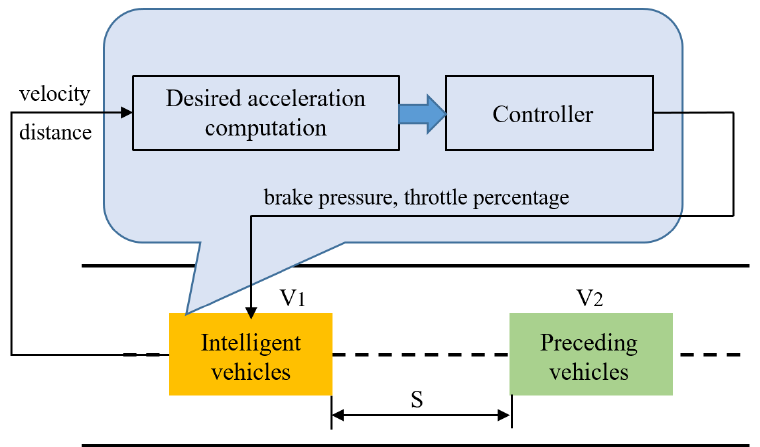
Figure 5. Calculation logic of desired